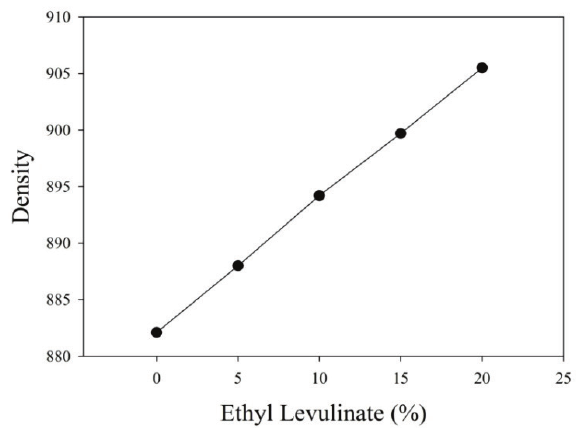
Figure 1: Effect of ethly levulinate amount on the density of the fuel mixture.